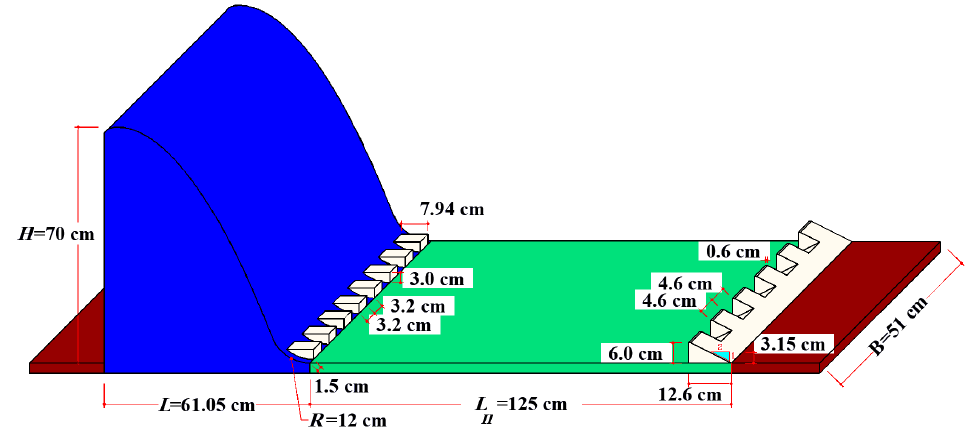
Figure 2. Dimensions of spillway and accessories installed in basin II Figure 2. D imensions of spillway and accessories installed in basin II . Figure 2. D imensions of spillway and accessories installed in basin II .